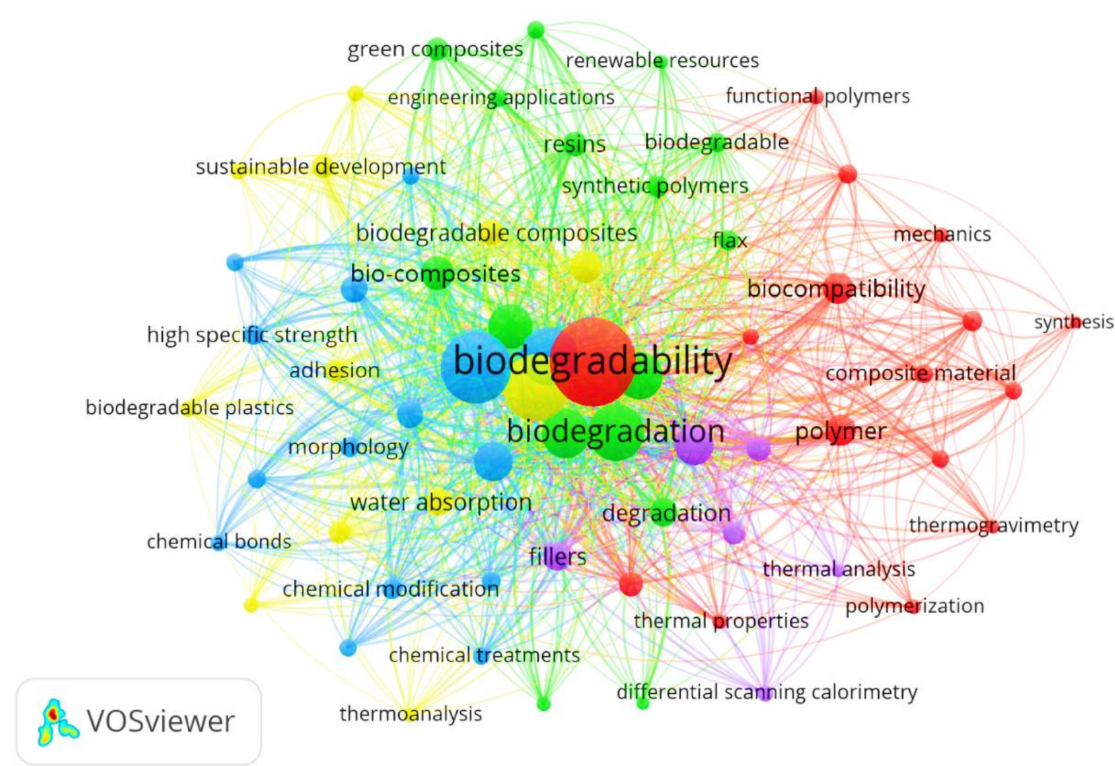
Figure 3. Systematic mapping summary of scientific advancements on polymer bio-nanocomposites for Multifunctional ap- plications in anti-static, anti-corrosion, actuators, sensors, shape memory alloys, biomedical application, flexible electronics, solar cells, fuel cells, supercapacitors, LEDs, and adhesive